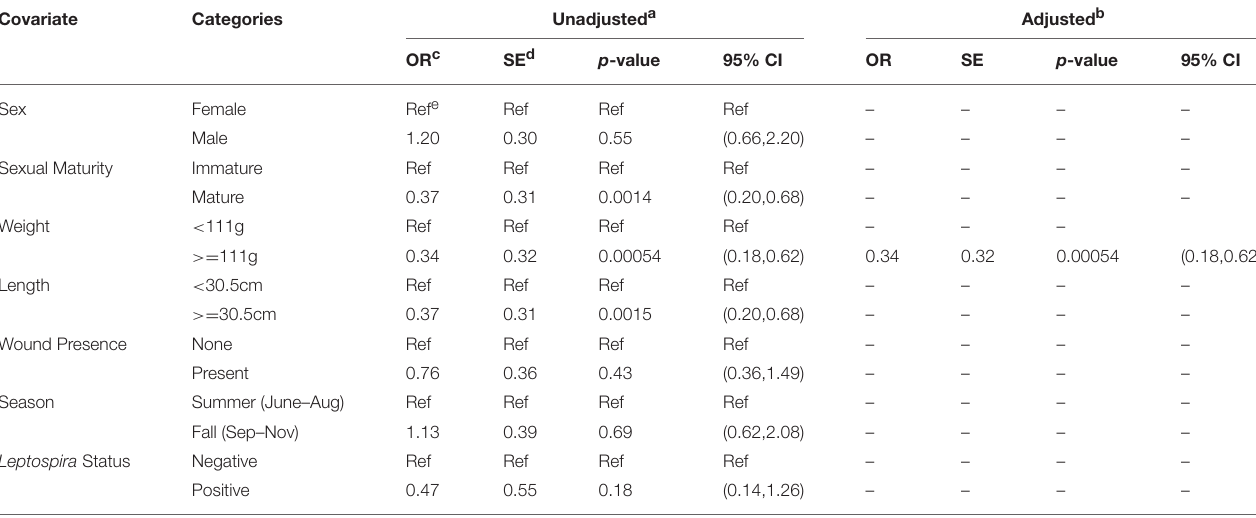
TABLE 3 | Unadjusted (bivariable) and adjusted (multivariable) logistic regression of each rat characteristic against the outcome of binary recapture (yes/no).